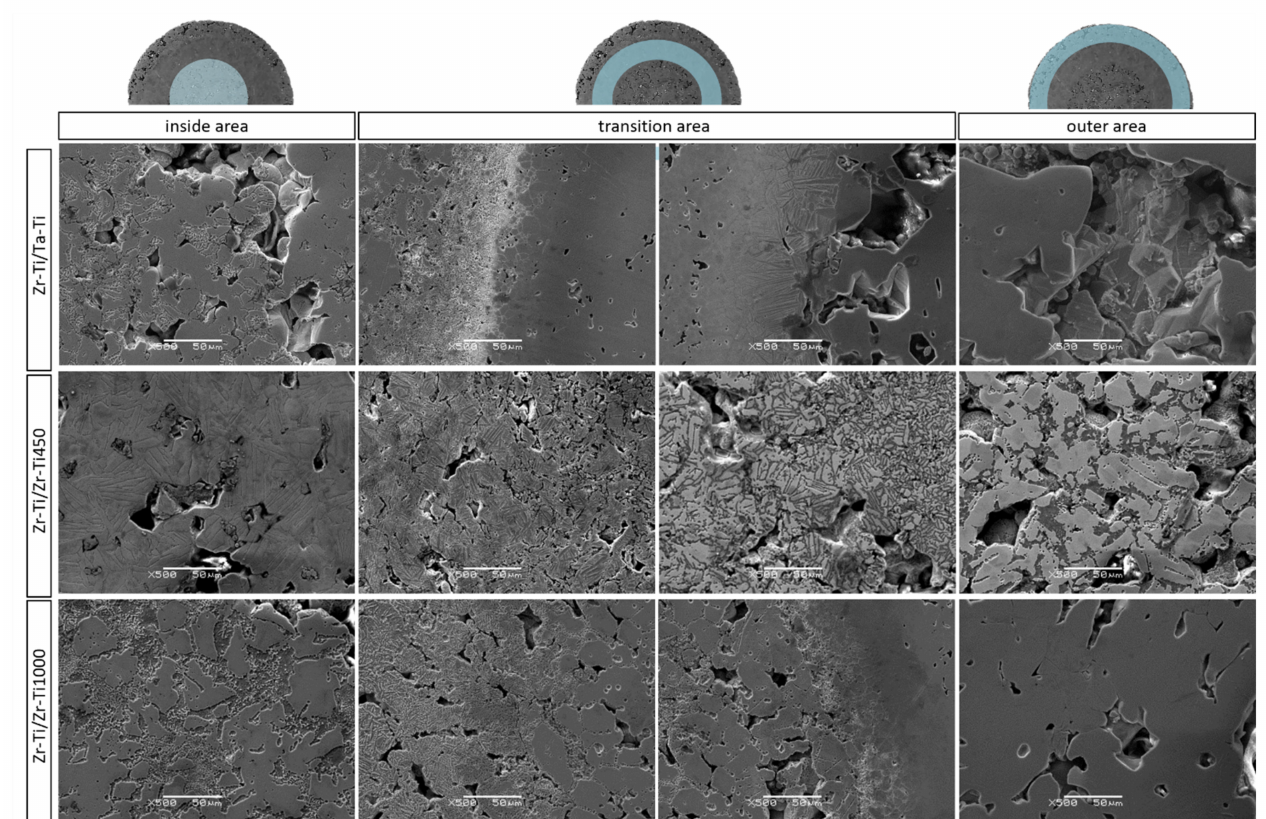
Figure 3. SEM images, with higher magnification, of the sintered